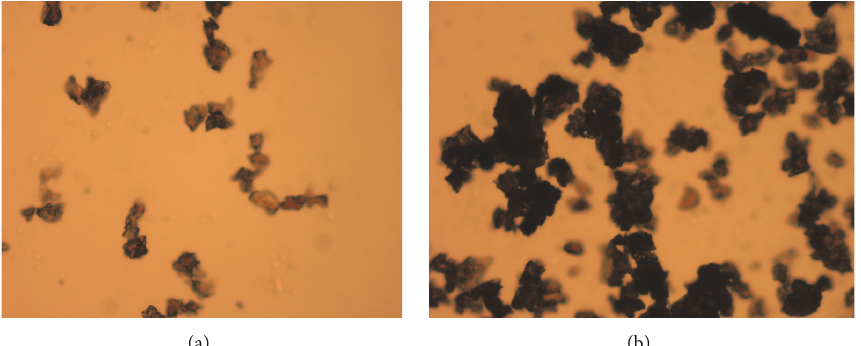
Figure 4: Microscopy images of grains of the “Traditional” roasted ground coffee sample (a) and a “Gourmet” coffee sample